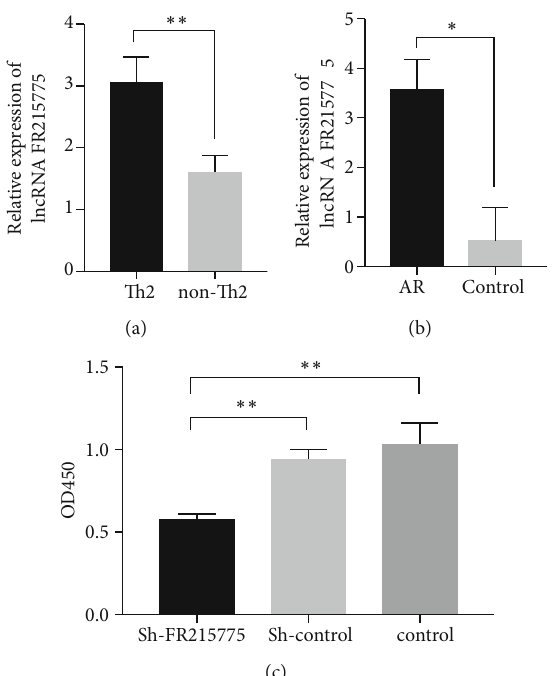
Figure 2: The relative expression of lncRNA FR215775 and the CD4+T cells proliferation. (a) Expression of lncRNA FR215775 was highly in primary Th2 cells and (b) in AR mice compared with the control group; (c) proliferation of cells in the FR215775 knockdown group was signi fi cantly inhibited compared with the control group ( ∗ P < 0 : 05 ; ∗∗ P < 0 : 01